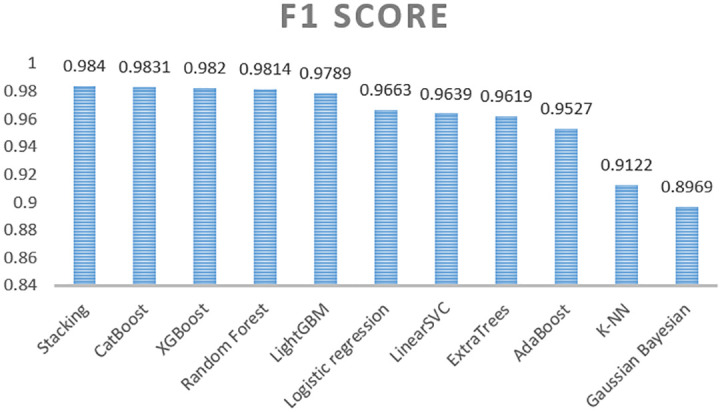
Comparison of F1 scores of each model.